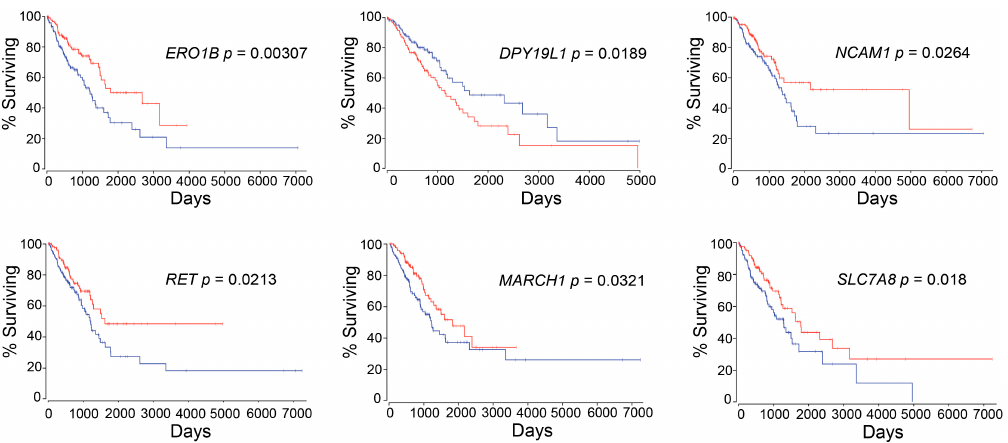
Figure 4. Newly identified survival-associated genes. The red line represents high-expression subtype, and the blue line represents low-expression subtype.